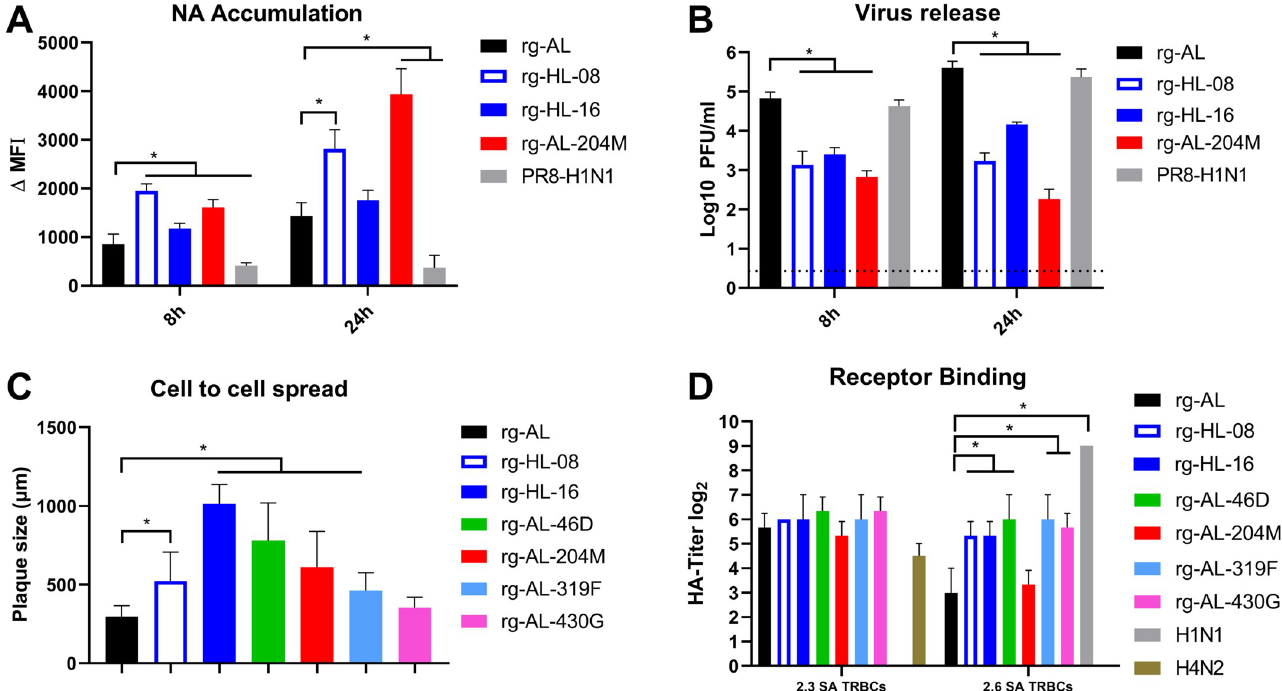
Fig 7. NA accumulation, virus release, cell-to-cell spread and affinity to modified turkey erythrocytes. MDCK-II cells were infected with the indicated viruses with an MOI of 1 for 8 and 24 h and the accumulation of NA on the plasma membrane was measured by flow cytometry and polyclonal anti-N1 antibodies. The results are the mean and standard deviation of three independent replicates (A). Virus release into the supernatant was determined by plaque test. The results are the mean and standard deviation of three independent replicates (B). Cell-to-cell spread of indicated viruses was assessed by measuring the size of 100 plaques induced in MDCK-II at 72 hpi using NIS Nikon Software (C). Viruses were adjusted to 32 HA units using chicken erythrocytes. Shown is the HA titer of indicated viruses against resialiated turkey erythrocytes carrying avian 2,3- or human 2,6-sialic acid (SA). The HA test was conducted in three independent experiments (D). Asterisks indicate significant differences compared with rg-AL at p < 0.05.